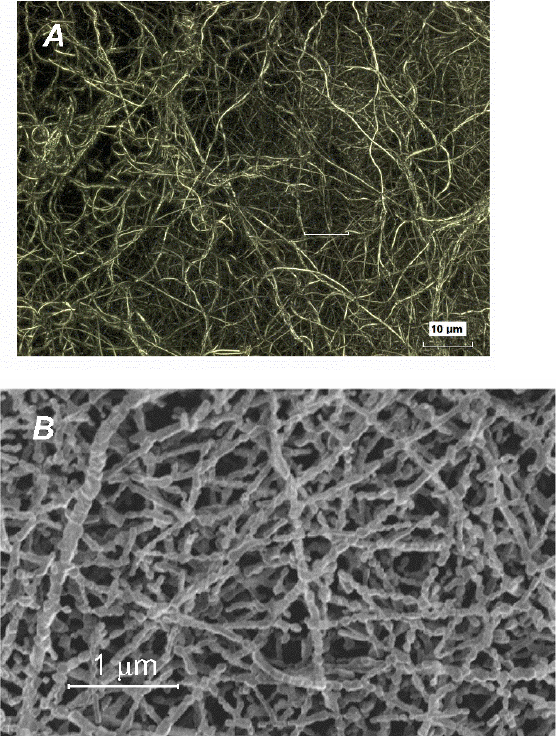
Figure 1. (Na,K)NbO 3 nanofibers calcined at 800 °C in air. ( A ) Large depth-of-field optical image captured by 3D laser scanning microscope Keyence VK-9710; ( B ) SEM image copied by means of JEOL JSM -7500FA field emission scanning electron microscope. TEM scans enable atomic resolution of NKN fibers crystallinity. As an example, Fig-